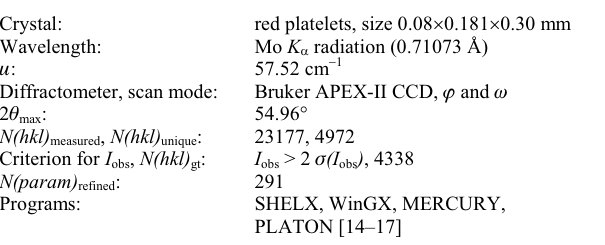
Table 1. Data collection and